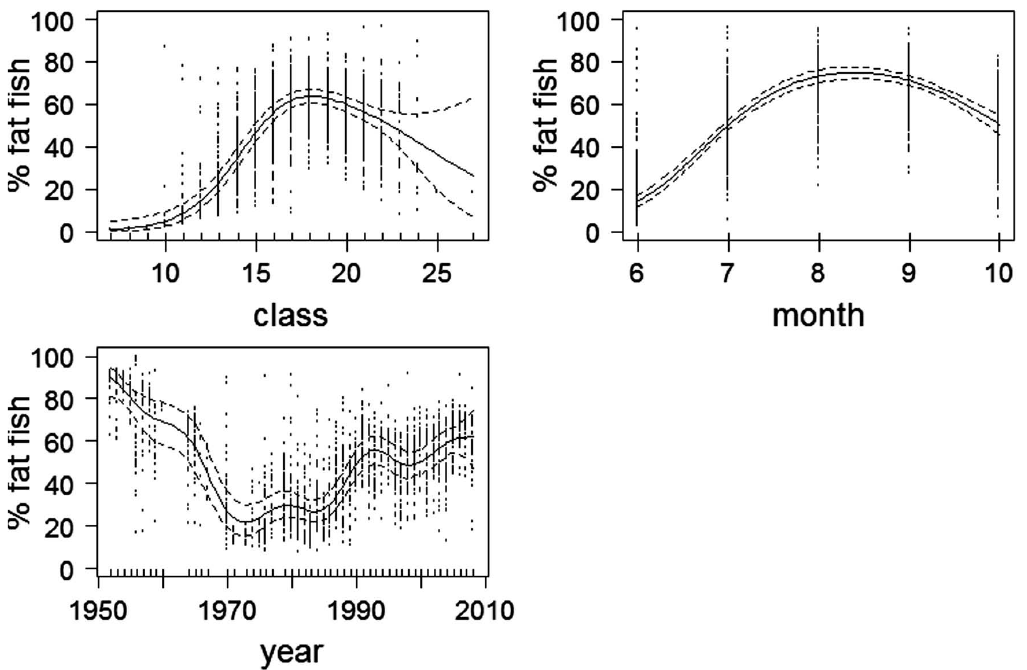
Fig . 6. – Plots of the smooth functions of the GAM fit to the percentage of fat individuals in relation to length class, month and year (see Table 2). Fat fish correspond to individuals in visceral fat stage >2 in the growing season, June-October. Continuous lines show model predicted values; dashed lines show ±2 standard errors. Symbols correspond to partial residuals.